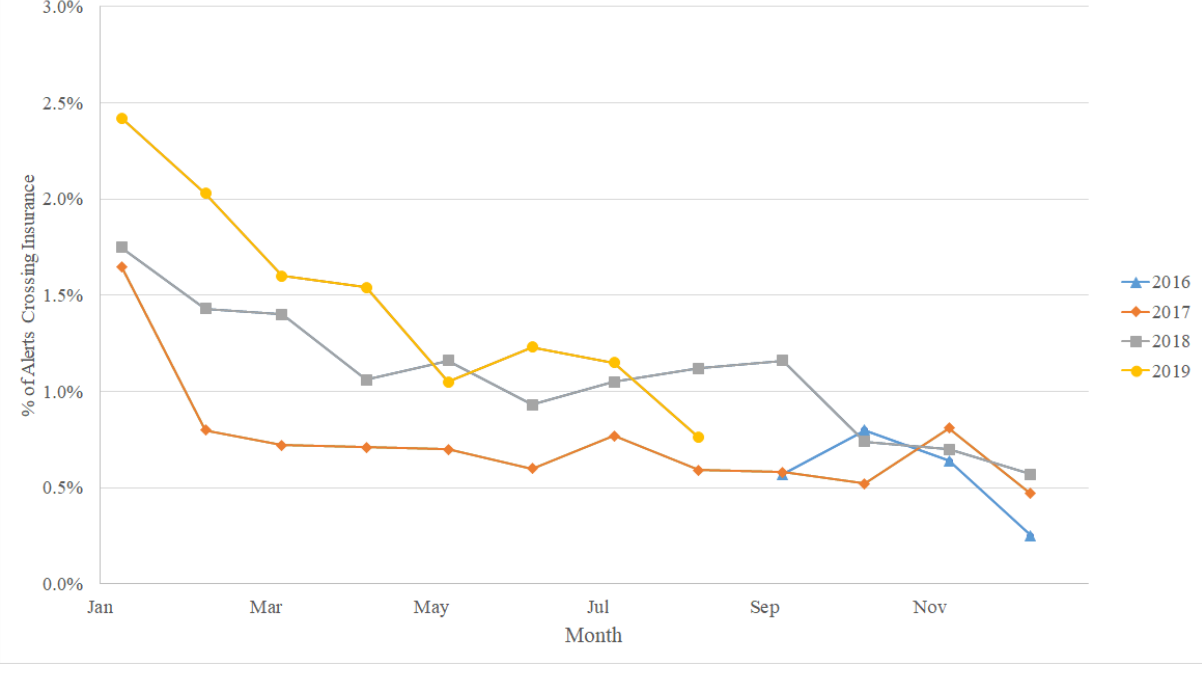
not spike in the first quarter. The percentage of serious drug-drug interaction crossover alerts among patients enrolled in an Affordable Care Act Exchange Plan was higher (85/6173, 1.4%; P